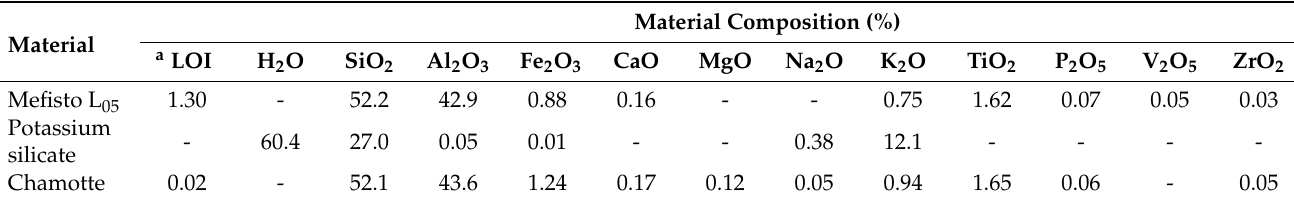
Table 1. Chemical composition (wt%) of raw materials according to XRF